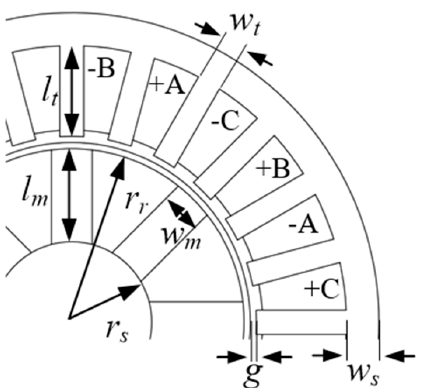
Figure 5. Interior permanent magnet synchronous machines (IPSM) model geometry with 24 slots.